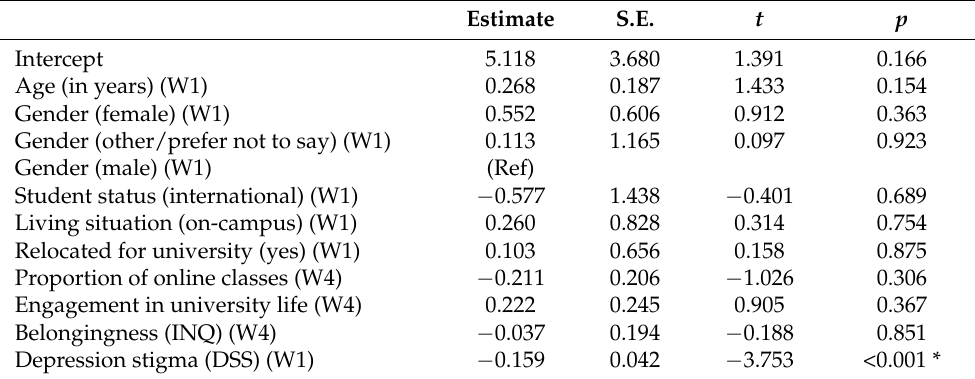
Table 3. Linear regression model for help seeking attitudes at Wave 4 ( N =